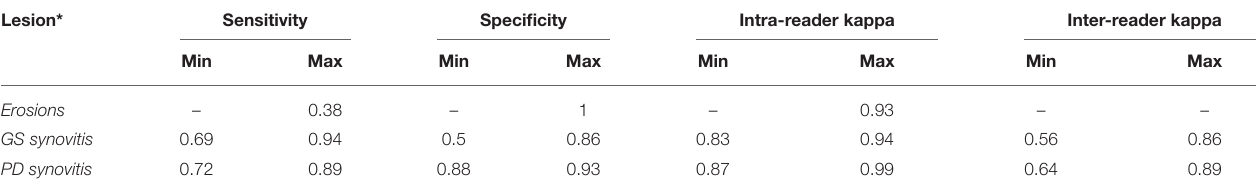
TABLE 3 | Performance of ultrasound to detect RA by elementary lesions and reliability.